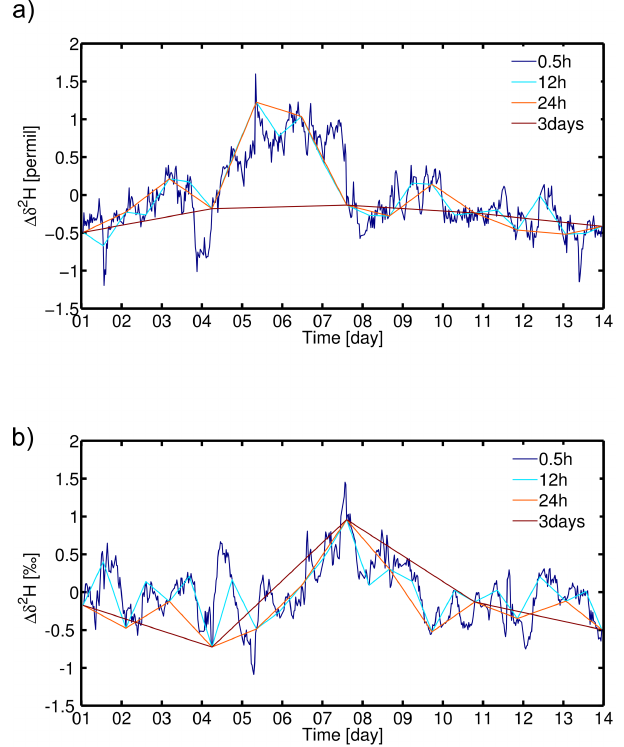
Fig. 8. Temporal evolution of the bias correction amplitude of iso- tope measurements with L1115-i (a) and WVIA (b) at 15700ppmv water vapour mixing ratio over 14 days. Each line corresponds to one calibration frequency scheme. The dark blue correction curve is obtained if the instrument is calibrated every 30min.